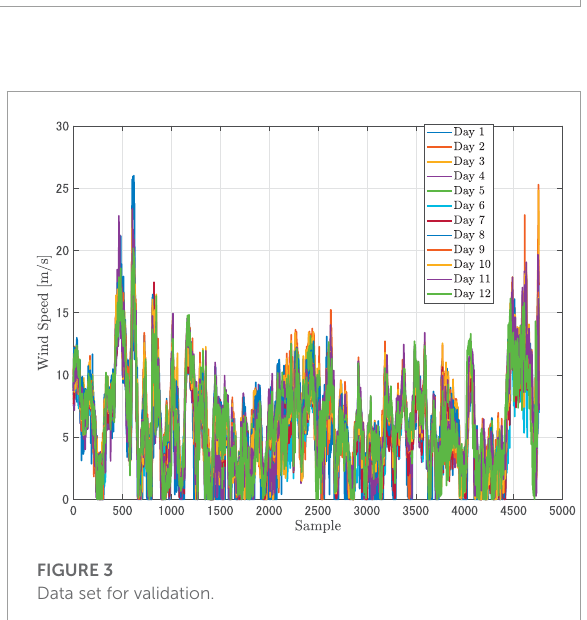
FIGURE 3 Data set for